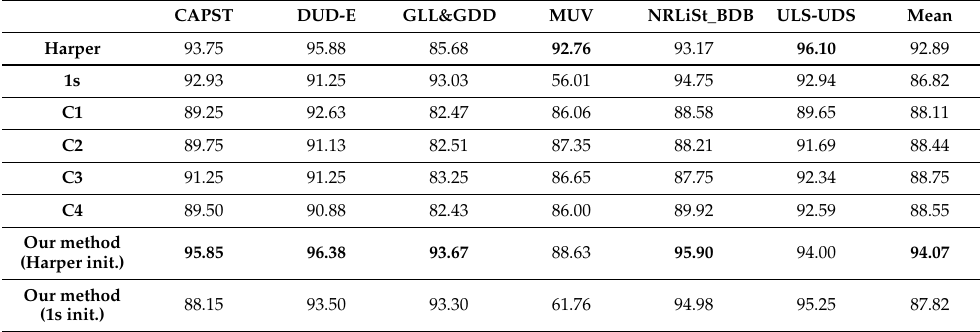
Table 6. Accuracy (%) obtained in each dataset. In bold, the highest ones. The last column shows the mean